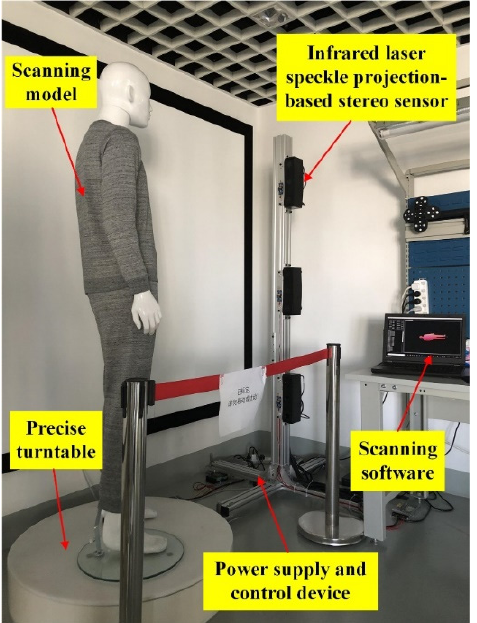
Figure 6. Multi-sensor collaborative human body scanning system.